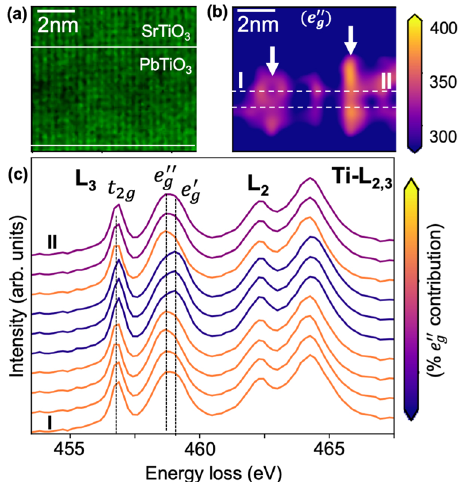
Fig. 3 Atomic scale EELS mapping of polar vortices. a Atomic resolution Ti L edge STEM-EELS map acquired from the same region as Fig. 2a. The locations of two vortices are indicated by dashed white circles. b Intensity of the e 00 peak of the L 3 edge obtained by Gaussian fi tting after binning by g position. Increased intensity of the e 00 is observed in the PTO vortex core, g marked with white arrows. c EEL spectra extracted from along the I-II path indicated in b . At the vortex core, the contribution of e 00 is the largest g followed by the intermediate location and the vortex edge. A color bar guide indicating the relative amount of e 00 contribution for c is displayed on g the